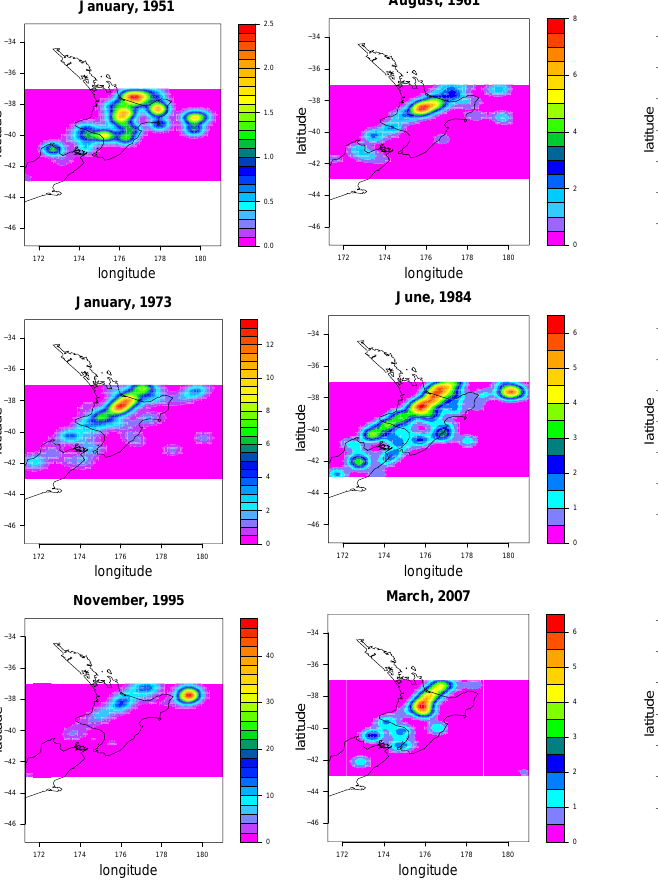
Fig. 6. Space-time-magnitude smoothed conditional intensity func- tion for M = 4 . 5 around a fixed point at six different times.